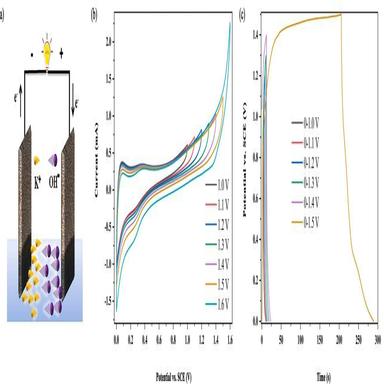
(a) Schematic diagram of CdSe (40 min) symmetric aqueous supercapacitor, Electrochemical performance of CdSe (40 min) symmetric aqueous supercapacitor (b) CV curves of different voltage windows with scanning rate of 100 mV/s, (c) GCD curves of different voltage windows with current density of 1 mA/cm2 .